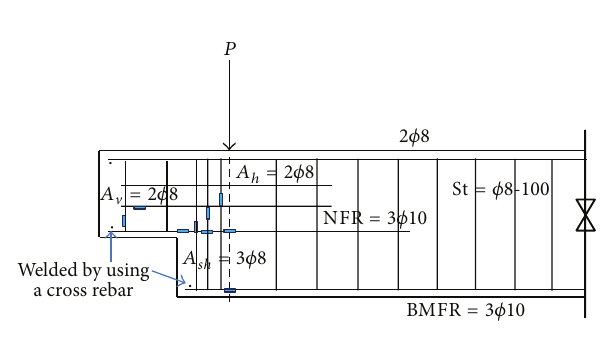
Figure 1: Reinforcement